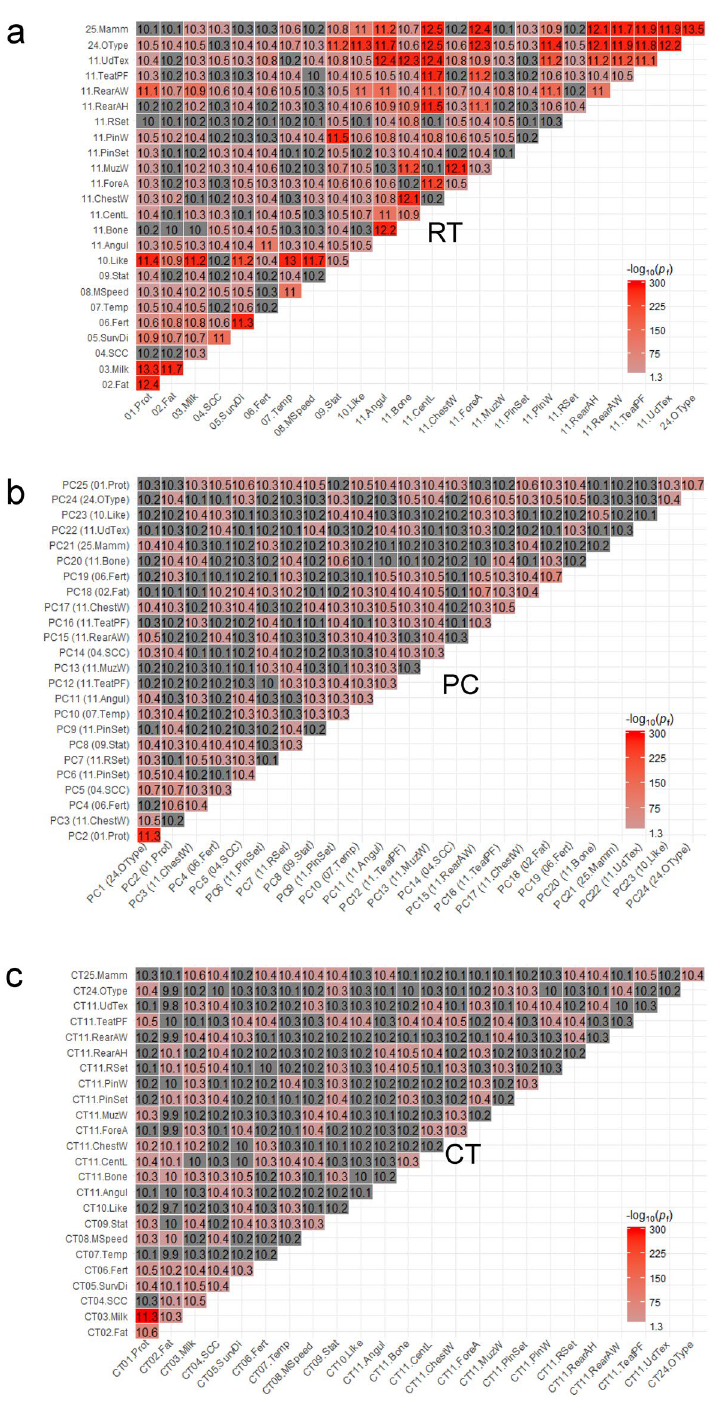
Figure 1. Overlap of SNPs detected by single-trait GWAS ( p s < 0.05) within raw traits (RTs, a ), principal components (PCs, b ) and Cholesky transformed traits (CTs, c ). Numbers in cells were rounded log2 count of shared SNPs between single-trait GWAS pairs. Overlap significances were based on Fisher’s exact tests ( p f ) accounting for the number of SNPs of each pair of single-trait GWAS and the total number of SNPs analysed. The RT associated with the top factor loading value of each PC was shown in the parentheses (Supplementary Table